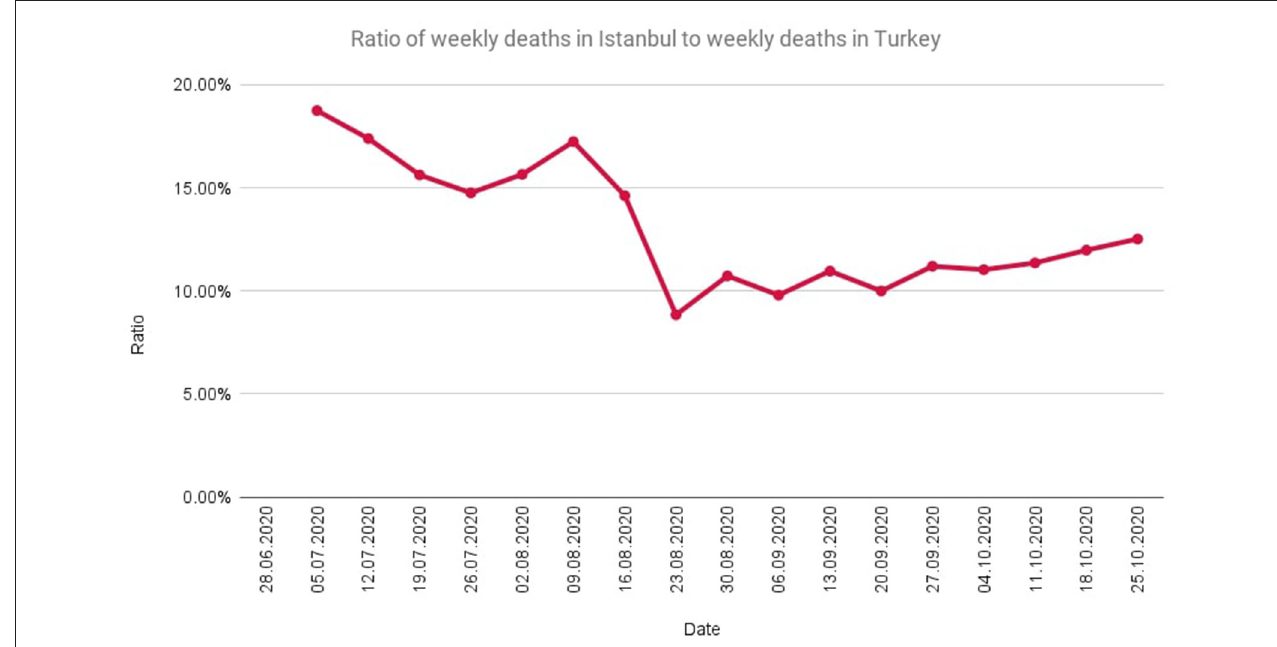
FIGURE 3 | The ratio of weekly deaths in Istanbul to weekly deaths in Turkey during the time period in which official reports are published.